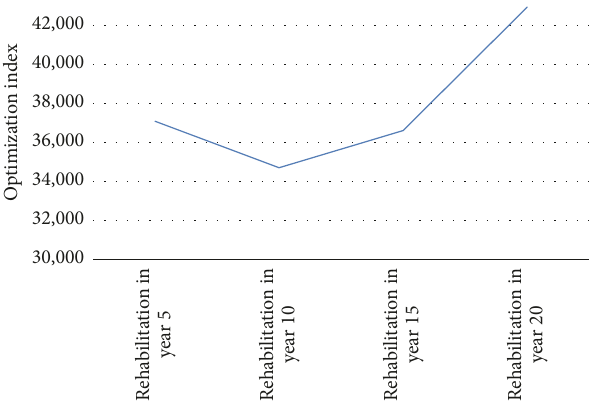
Figure 10: Optimization